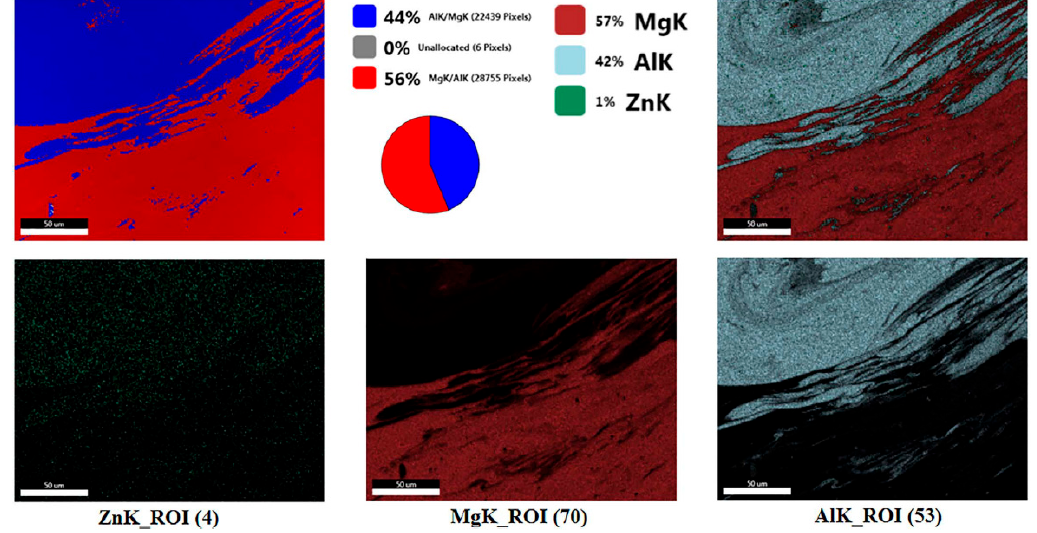
Figure 9. EDS elemental mappings from the FSPed AZ31B/AA7075 interface (adapted from reference [60], with permission from © Elsevier).